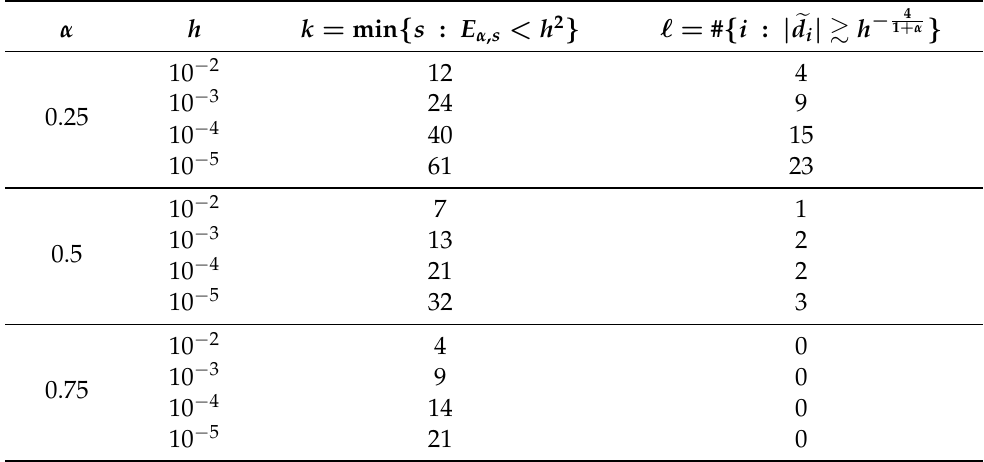
Table 1. Reduction possibilities for the homogeneous fractional Laplacian problem in the vicinity of the theoretical estimate